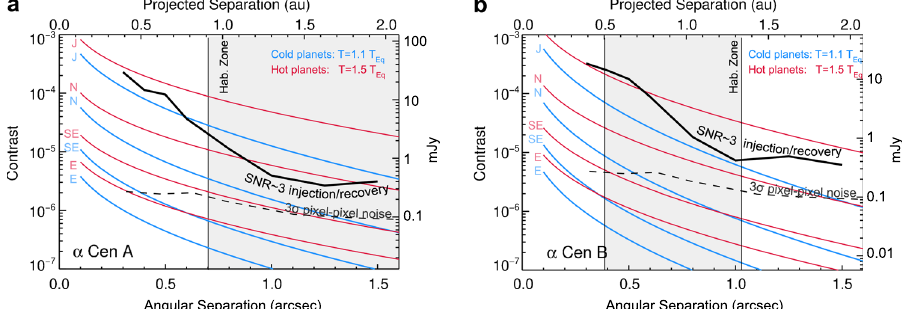
Fig. 4 Sensitivity of the NEAR data. Results for α Centauri A & B are shown in ( a ) and ( b ), respectively. The bold curve shows the sensitivity to point sources computed from simulated injection and recovery tests and the dashed curve shows the background noise contribution from the variation of pixel- to-pixel intensities. The red and blue curves represent simulated planets of equivalent radii to those in the solar system, with the addition of an R = 1.7 R ⊕ Super-Earth (SE). Each model planet ’ s temperature is set by the assumption of thermal equilibrium at a given separation with an A B = 0.3 Bond albedo and internal heating included as 10% or 50% of the equilibrium temperature; similar to conditions of the solar system planets 46,47